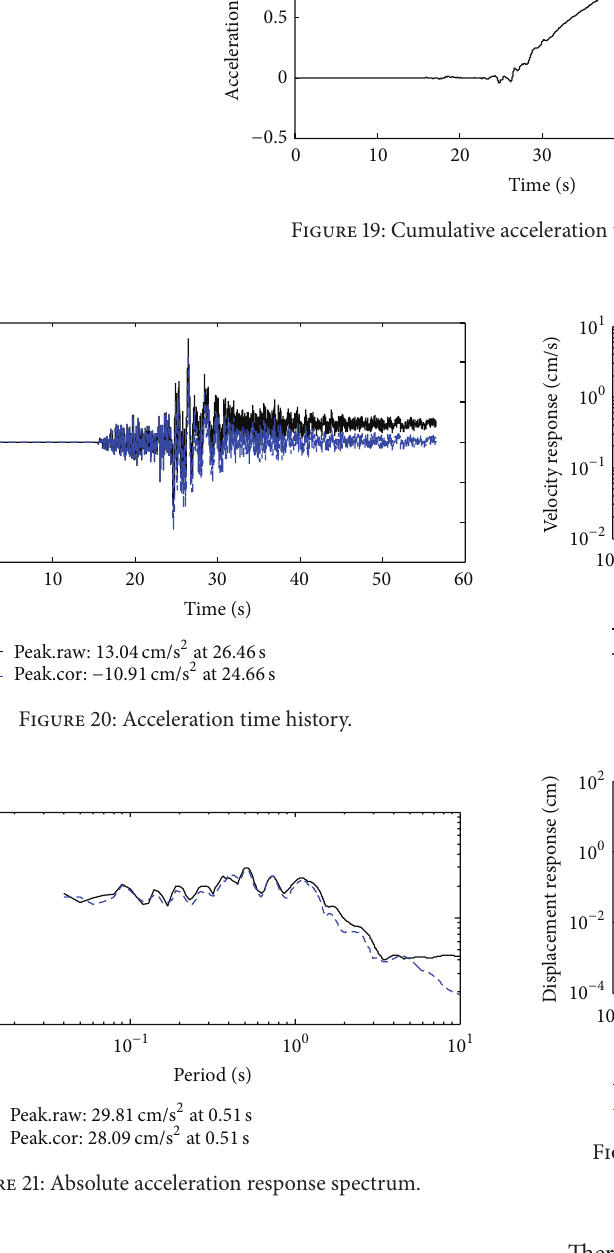
the position of PGA is ahead of 1.8 s. And the maximum abso- lute acceleration response spectrum reduces from 29.81 cm/s 2 to 28.09 cm/s 2 , and the decline is only 5.8%; however, the position of the maximum response stays unchanged. The relative velocity response spectrum increases from 4.34 cm/s to 4.38 cm/s, the decline is less than 1%, and the position of the maximum response shifts from 1.3 s to 1.21 s. In contrast, the maximum response of displacement reduces from 10.94 cm to 4.80 cm, and the decline reaches 56.1% to a larger extent; however, the position of the maximum response stays fixed.